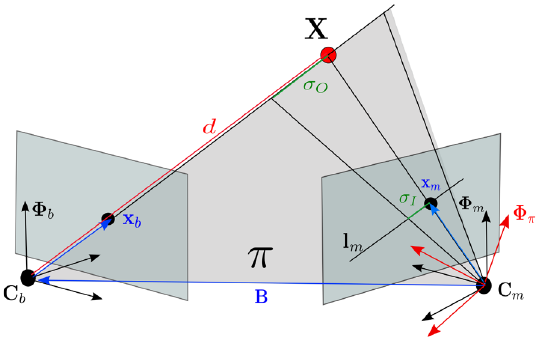
Figure 8. Structure computation in the epipolar